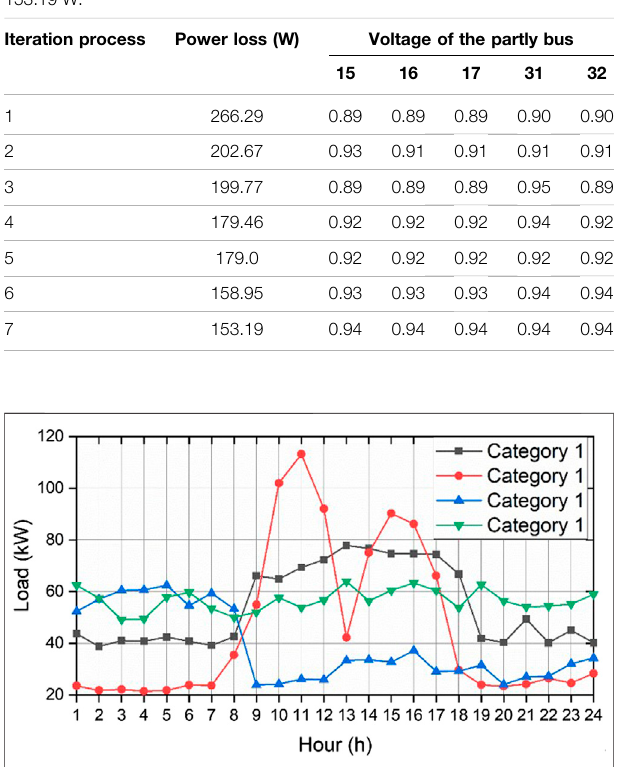
FIGURE 9 | Predicted load of partial prosumers.